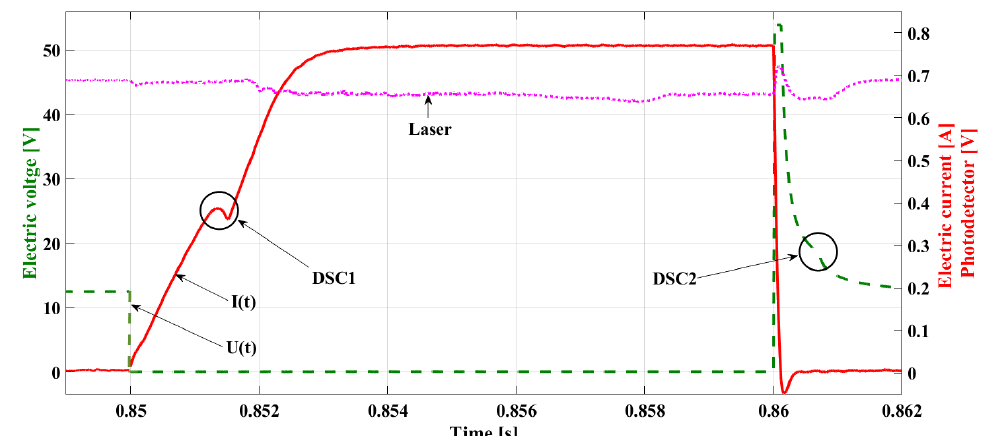
Figure 8. The current waveform of the dosing injector with marked ranges of needle lifting and dropping, DSC1 , and DSC2 .